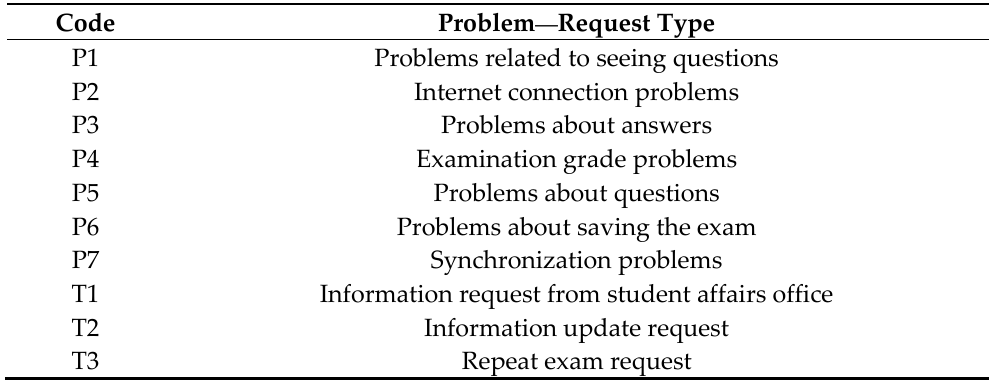
Table 1. Classified support request types and codes.